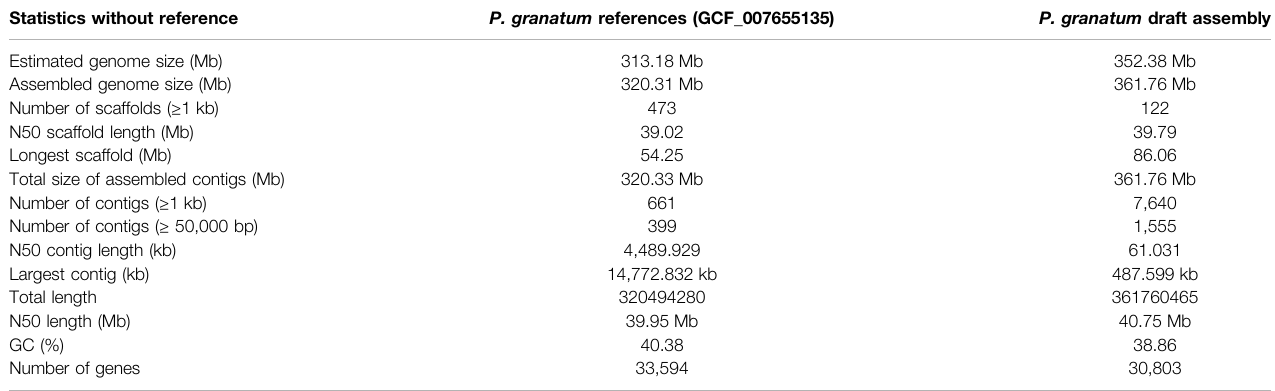
TABLE 1 | Statistics of draft genome assembly of P. granatum .